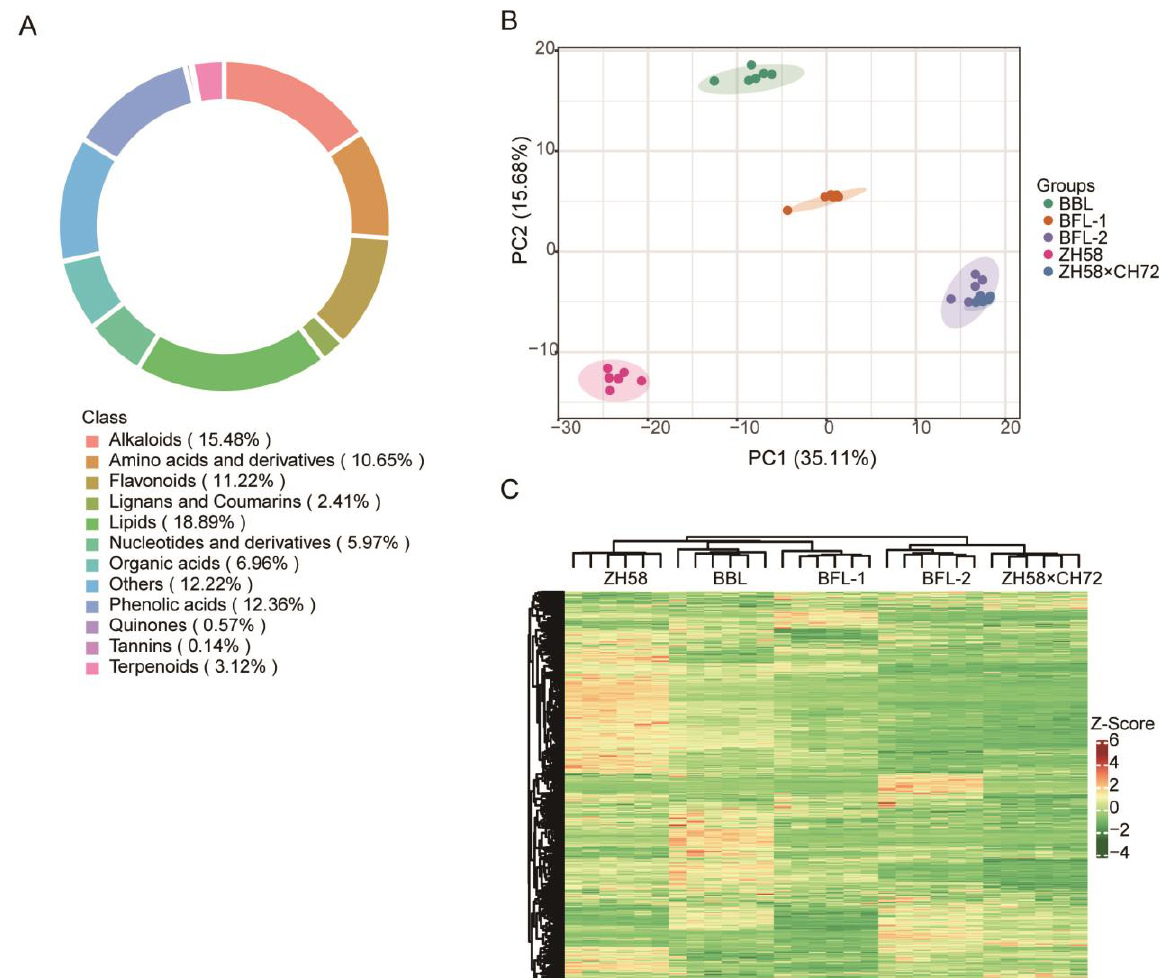
Figure 2. Metabolomic profiling of seeds of the studied maize varieties. ( A ) Circular plot of the metabolite class composition. ( B ) Principal component (PC) analyses of the amount of metabolite in the seeds of five maize varieties. Score plot of the first two PCs with the explained variance. ( C ) Hierarchical clustering of five maize lines using metabolite accumulation data. In the heatmap, all replicates of each maize line are visualized in a single column. Metabolite accumulation is shown in different colors, where red indicates high abundance and green indicates low relative